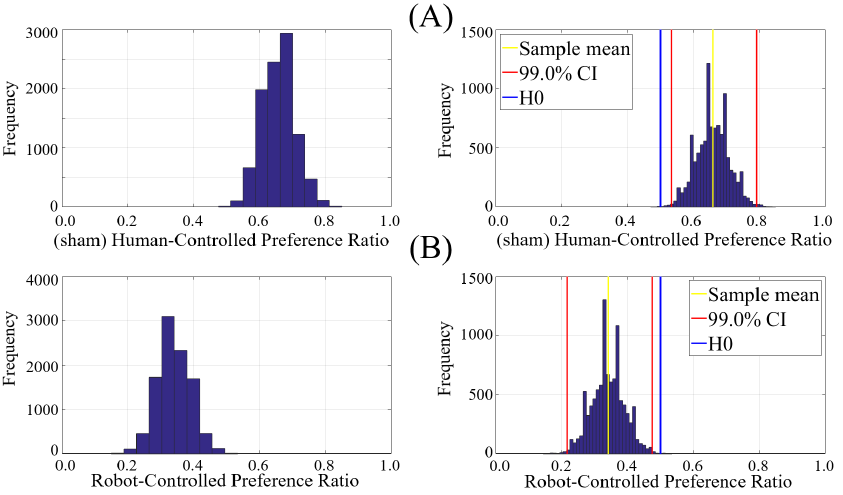
Figure 5. Testing Hypothesis 5 versus Hypothesis 6. ( A ) number of times ( sham ) human − controlled selected total number of responses − controlled selected ( B ) number of times robot . The left subplots show the histograms of these ratios. The total number of responses right subplots correspond to the results of their bootstrapped tests at 99.0% confidence interval (area within red lines). Tick blue lines mark the null hypothesis H0 (i.e., participants’ preference for two trials was at chance level) and yellow lines are bootstrapped averages. These subplots verify that whereas participants preferred (sham) human-controlled trial with a significantly above chance level, their preference for robot-controlled trial was significantly below chance level.